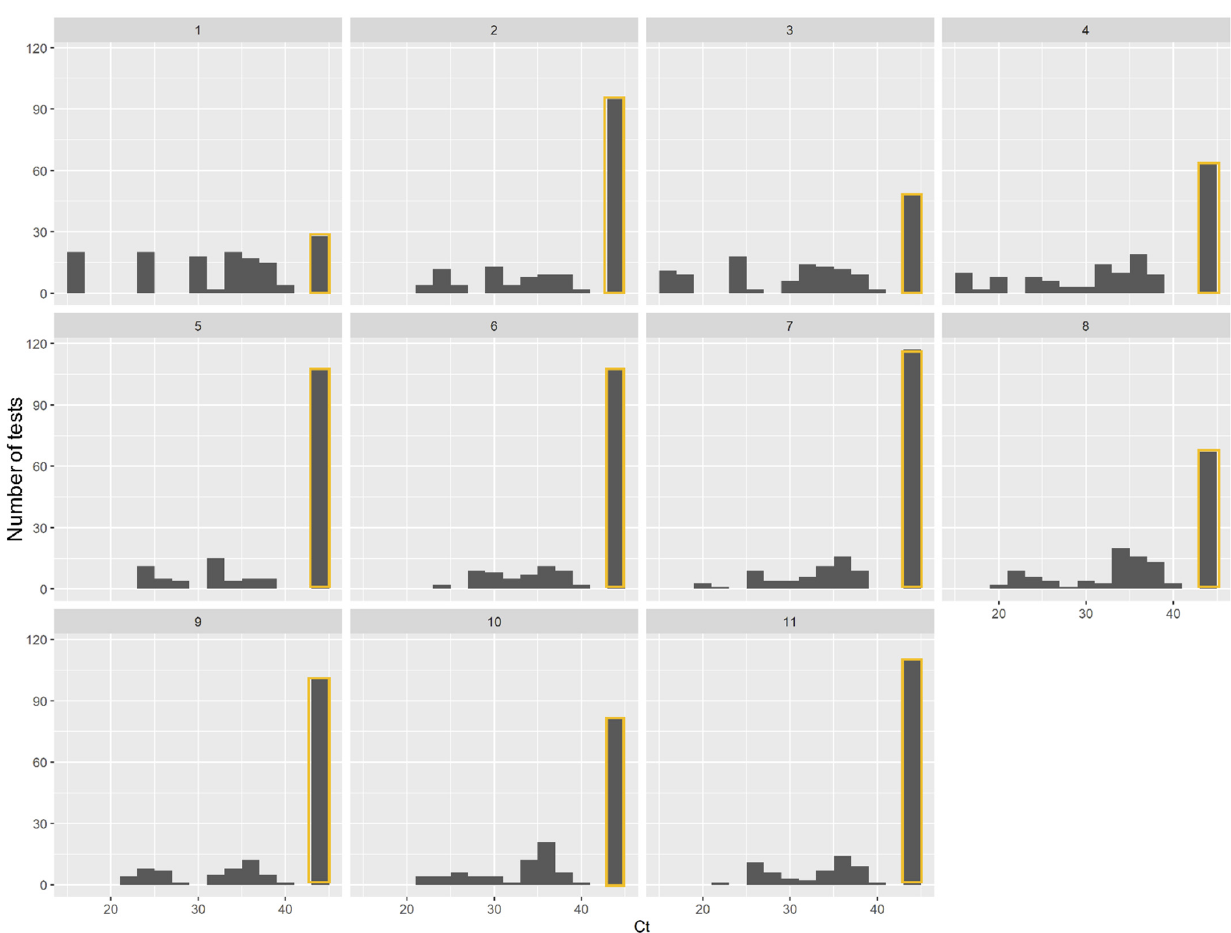
Figure 2. Number of positive Candida PCR test per Ct according to the 11 extraction methods. Negative results (Ct > 45 or no amplification detected) are stained orange.